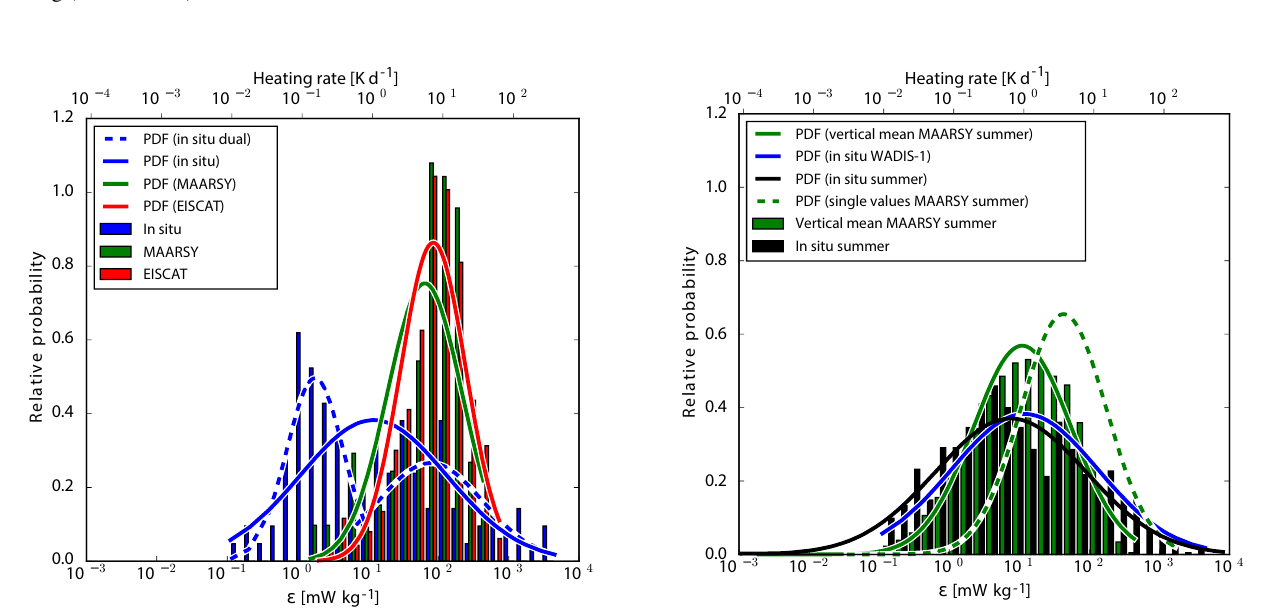
Figure 13. Distributions (histograms) of turbulence energy dissipation rates derived from the EISCAT, MAARSY, and in situ measurements in red, green, and blue, respectively, around the WADIS-1 launch. Solid lines show probability distribution functions (PDF) fitted to the corresponding histograms. Since the histogram of in situ data may suggest two subsets, it was additionally split at 10mWkg − 1 for the PDF fitting (dashed lines).